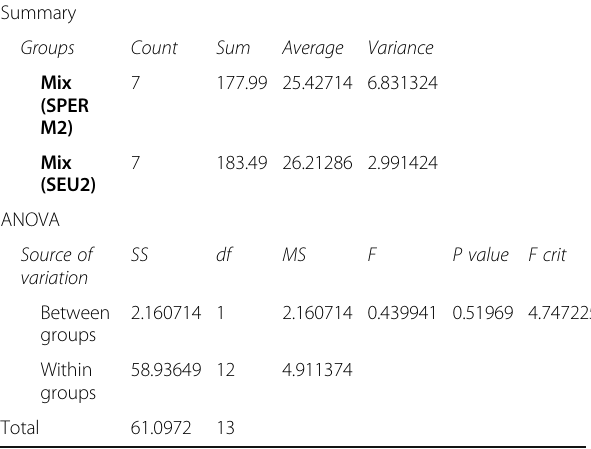
Table 3 ANOVA of results of amplification of the two semen- specific DNA methylation markers in mixed body fluids Summary